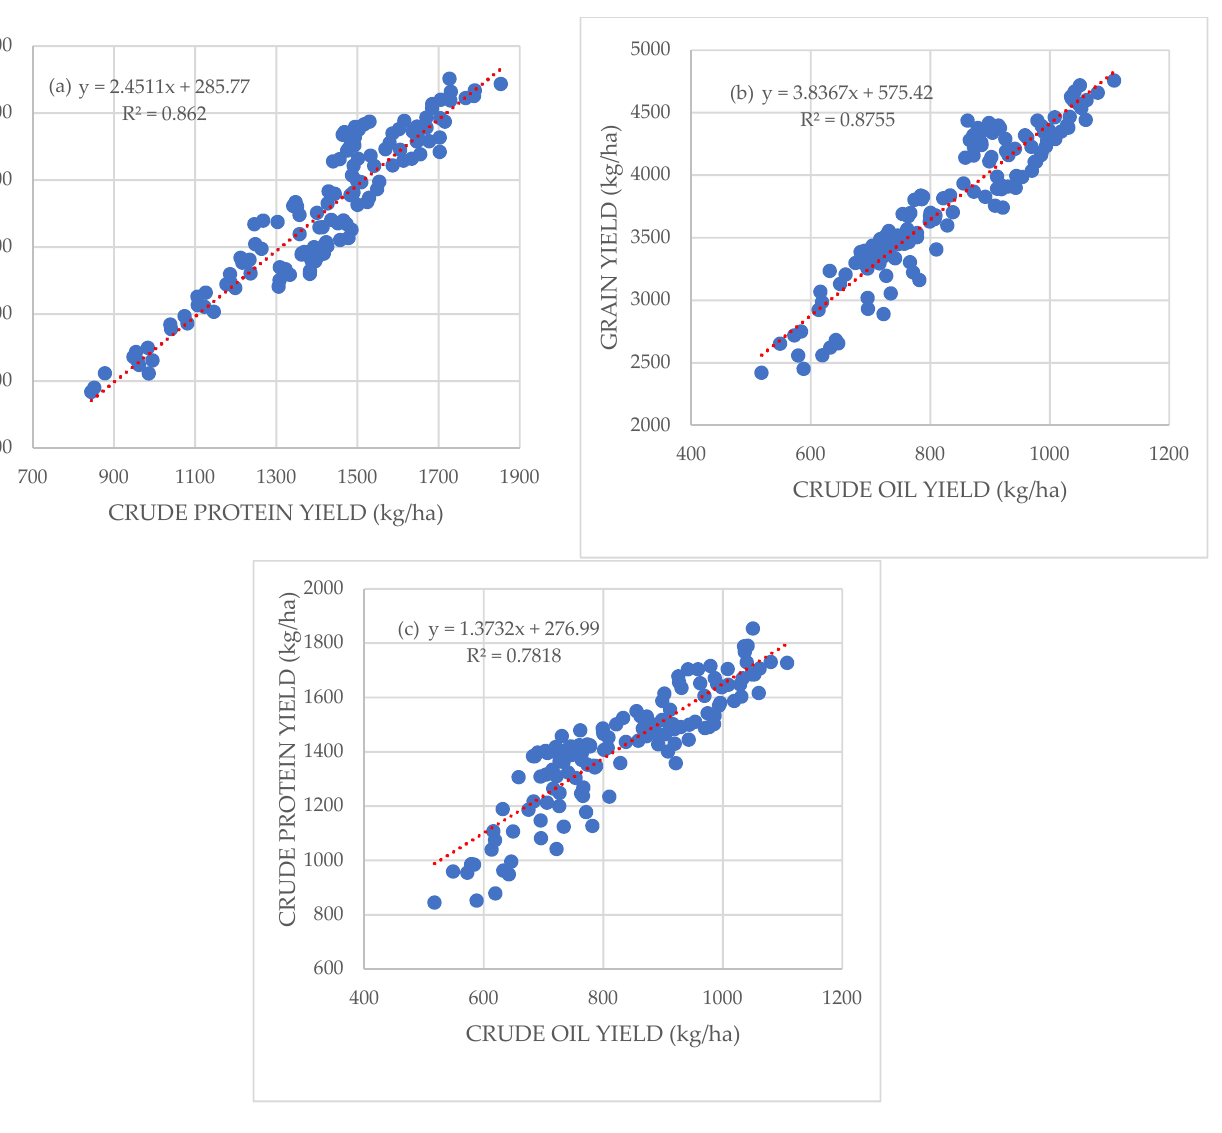
Figure 4. Linear regressions between ( a ) the crude protein and grain yields, ( b ) the crude oil and grain yields and ( c ) the crude oil and crude protein yields.